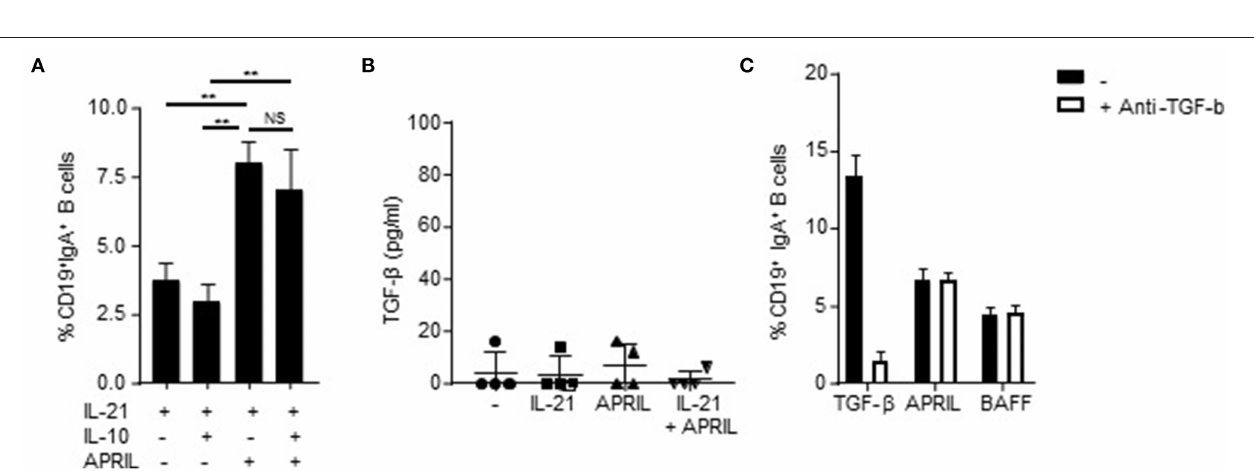
FIGURE 2 | (E) Frequencies of CD19 + IgA + B cells after 6 days. N = 4-7, mean ± SD are shown. * P < 0.05 (one-way ANOVA with Bonferroni multiple comparison test). (F) Detection of IL-10 by ELISA in the supernatants of stimulated B cells at day 6 of the culture. Mean ± SD are shown, n = 5. * P < 0.05, ** P < 0.01 (one-way ANOVA with Bonferroni multiple comparison test). (G) APRIL-induced IgA + B cells produced high amounts of IL-10 after 6 days of culture without additional stimulation like CpG or PMA/IO, as measured by flow cytometric analyses of double-stained cells for IgA and IL-10. Mean ± SD are shown, n = 5. *** P < 0.001 (two-way ANOVA). (H–J) Recent class switching to IgA was detected by the presence of mRNA transcripts for I α 1-C α 1 (H) , I α -C µ (I) , and AICDA (J) measured by quantitative real time RT-PCR. Mean ± SD are shown, n = 3.